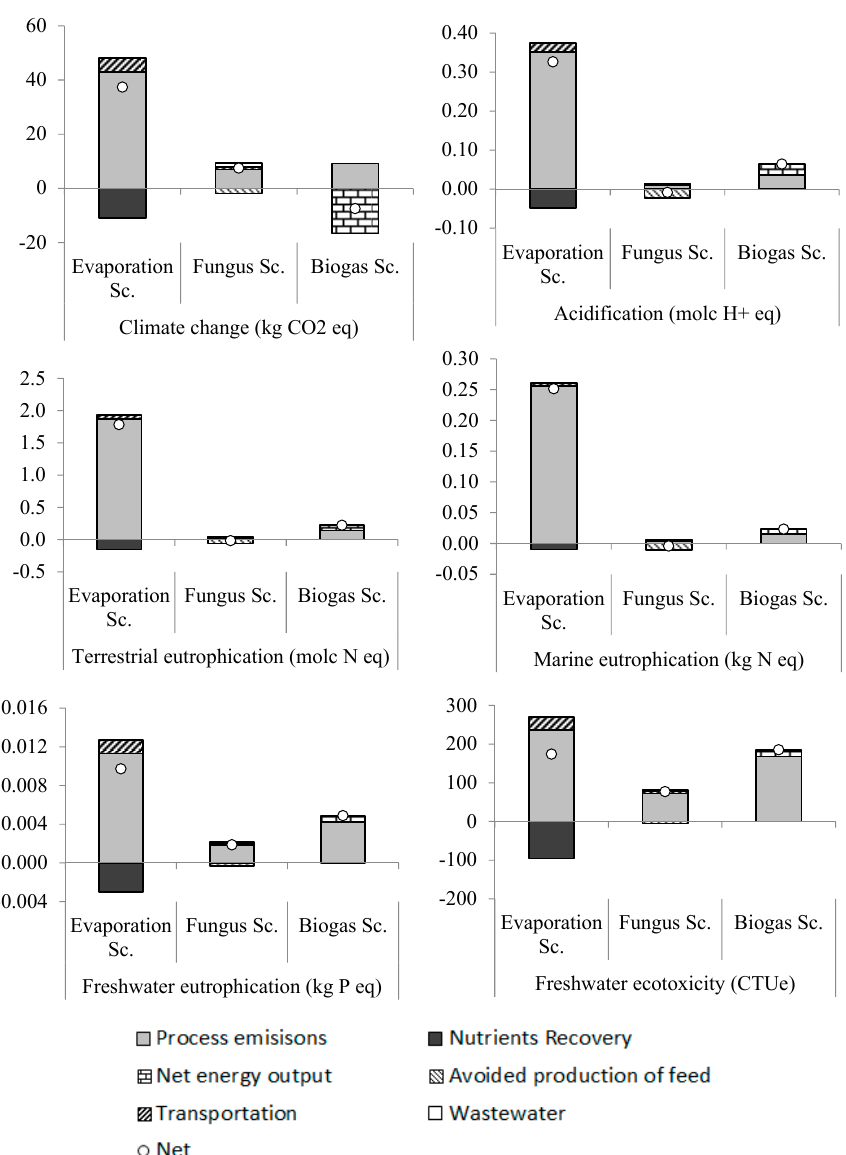
Figure 5. Environmental impacts of the three scenarios studied in this work.